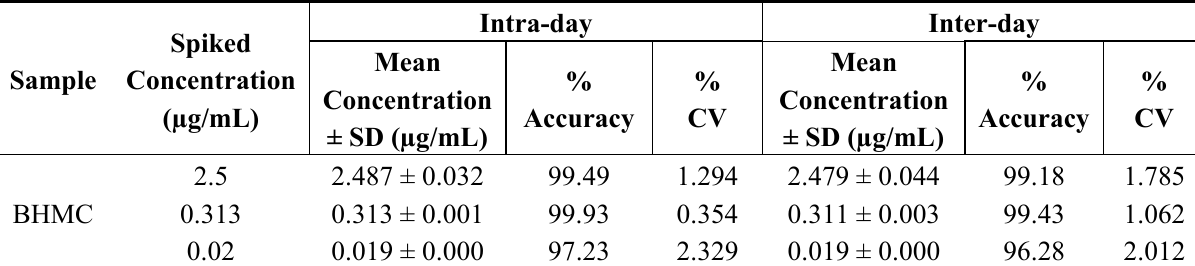
Table 2. Precision and accuracy test with intra-day and inter-day